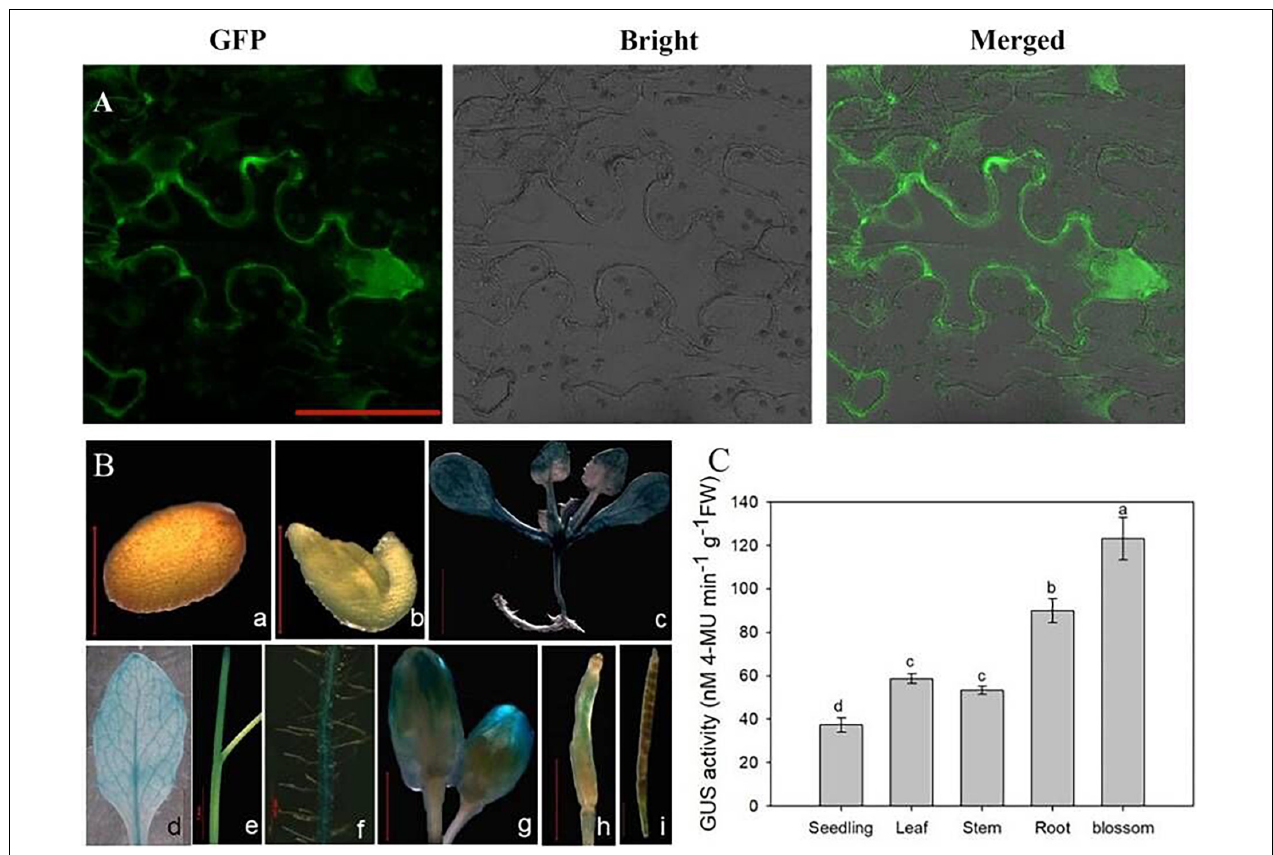
FIGURE 2 | Subcellular localization, tissue expression, and quantitative analysis of OsCIPK17 . (A) Subcellular localization of OsCIPK17 . (B) The expression of OsCIPK17 by GUS staining. (C) Quantitative analysis of GUS activity of OsCIPK17 in Arabidopsis tissue by fluorescence method. Different lowercase letters above the bar of panel (C) indicate that there were significant differences among the tissues at p <